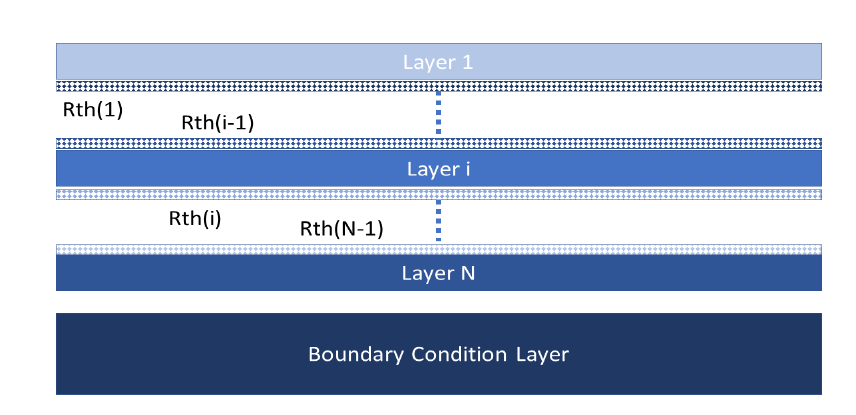
Figure 3. Schema of multilayer with thermal resistance and a boundary